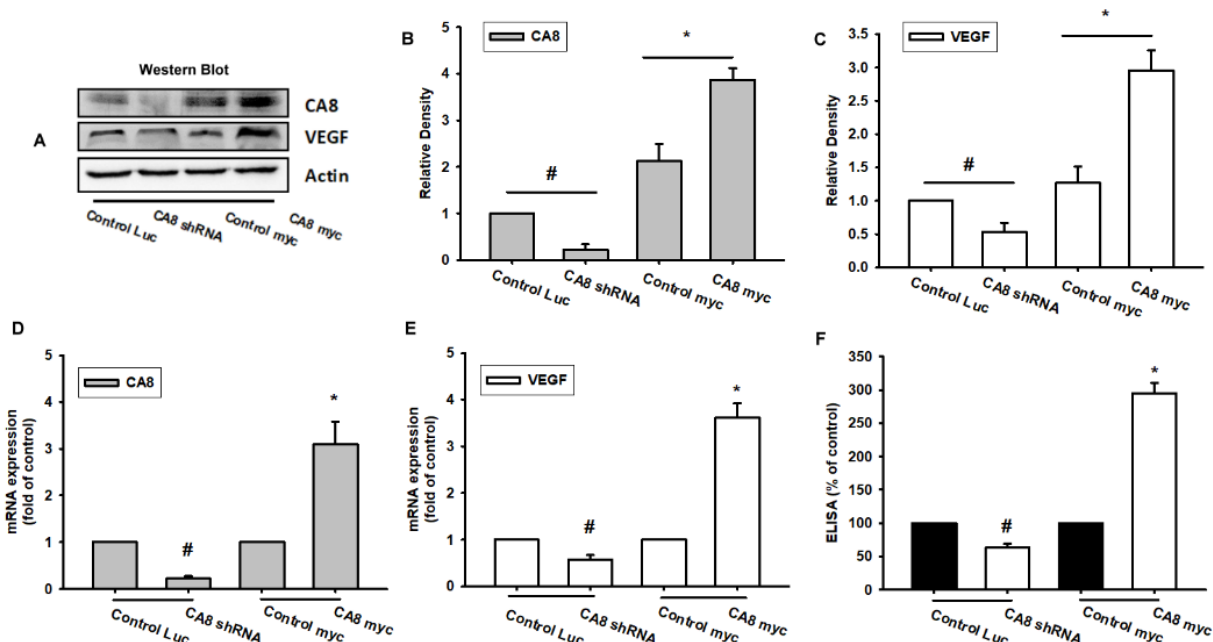
Figure 2. CAVIII reduces VEGF expression in knockdown CA8 CRC cells and increases VEGF ex- pression in CA8 overexpression CRC cells. CRC cell lines included SW480/control Luc, SW480/CA8 shRNA (CA8 knockdown expression), SW480/Control myc, and SW480 CA8 myc (CA8 overexpres- sion). ( A – F ) Comparison of the CAVIII or VEGF expression in different grades of CAVIII expression in CRC cells was examined by qPCR, ELISA, and Western blotting. Results are expressed as the mean ± SEM. * p < 0.05 compared with controls. # p < 0.05 compared with the control group.